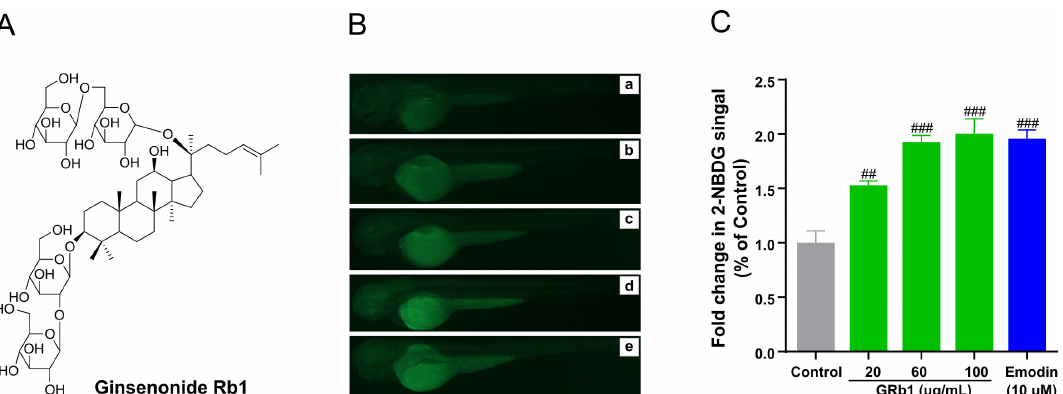
Figure 2. GRb1 induces 2-NBDG uptake in zebrafish larvae. ( A ) Chemical structures of ginsenoside Rb1. ( B ) Fluorescence microscopy images of zebrafish larvae treated with different concentrations of GRb1 (20, 60, 100 μg/mL) with 10 μM emodin as a positive control. Control ( a ), 20 μg/mL GRb1 ( b ), 60 μg/mL GRb1 ( c ), 100 μg/mL GRb1 ( d ) and 10 μM emodin ( e ). ( C ) Fold change in 2-NBDG absorption quantified by Image J. Results are expressed as mean ± SEM. ### p < 0.001, ## p < 0.01 vs. control.